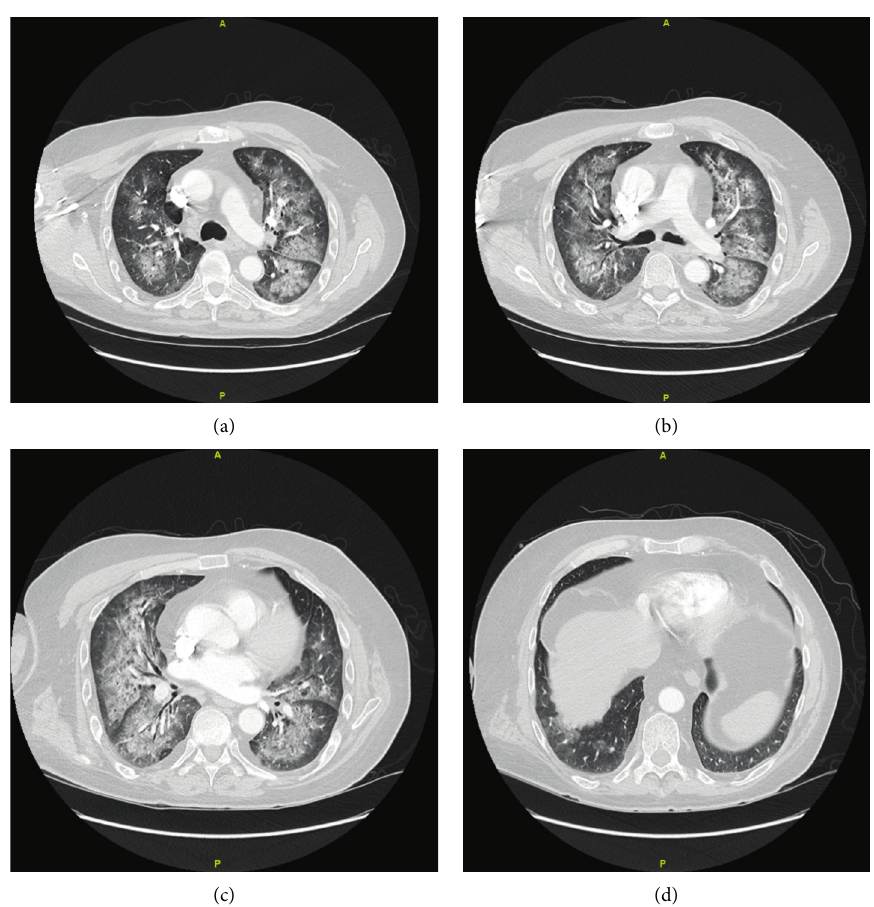
Figure 3: Extensive patchy airspace disease on CT scan of the chest with